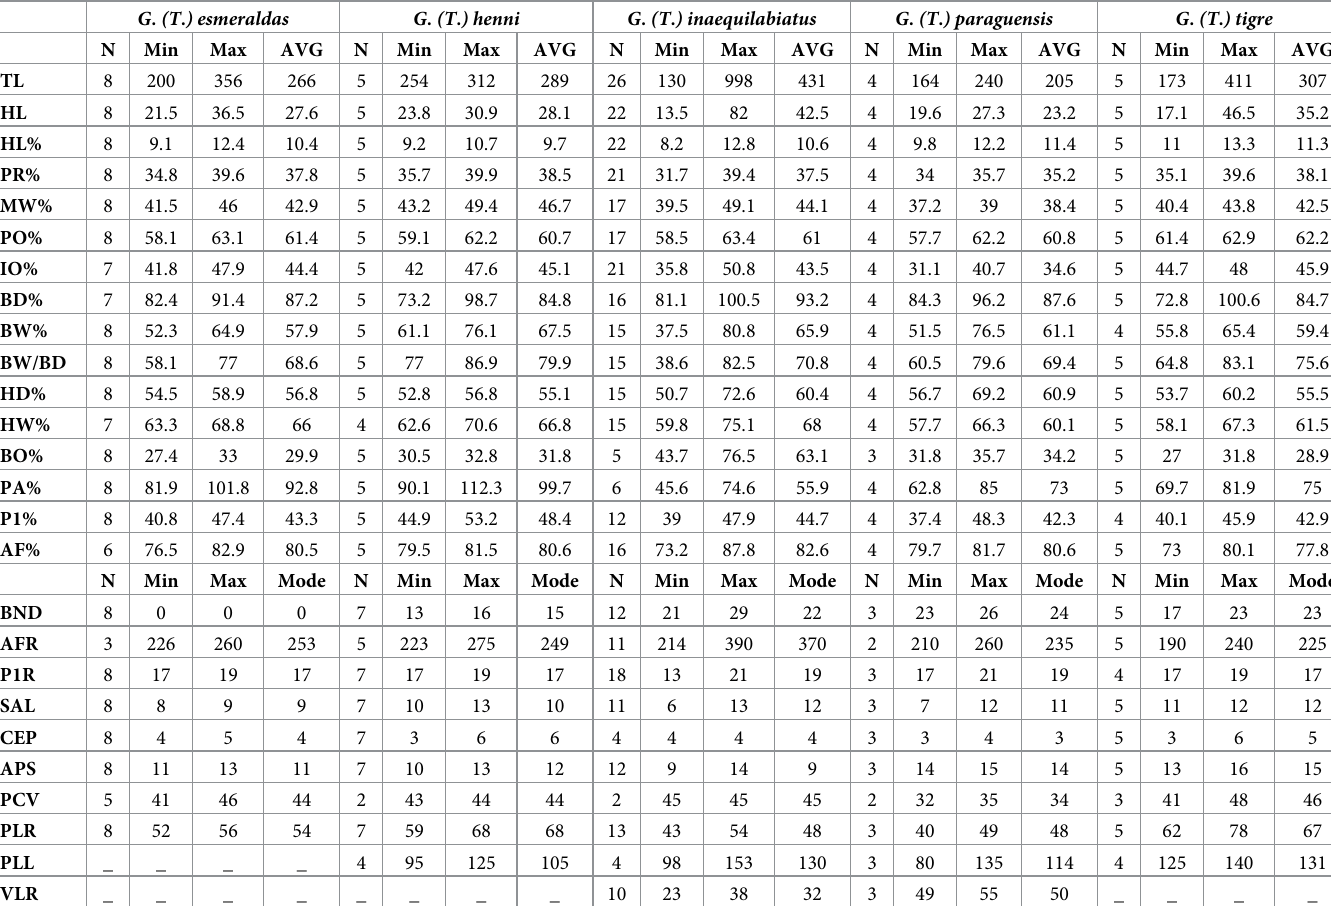
Table 15. Summary of morphometric and meristic data for five species of Tigre . Data for 46 specimens. G . (T . )